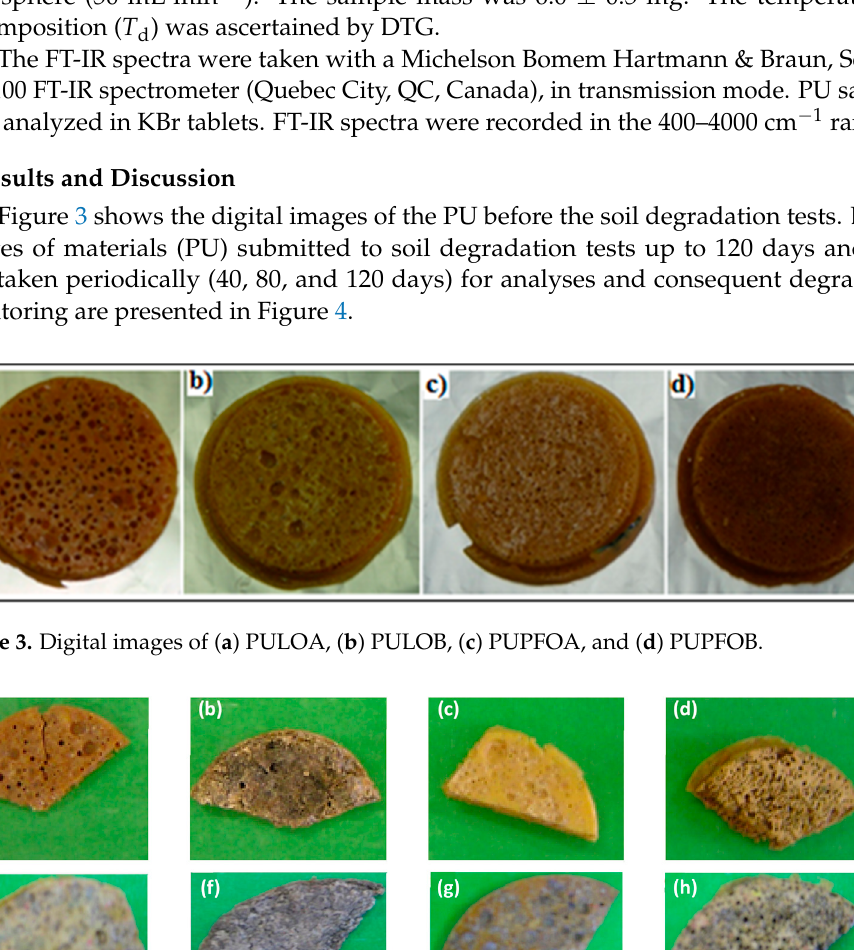
Figure 2 . ( a ) Samples placed in the soil, ( b ) flasks filled with prepared soil, and ( c ) sample incuba- tion.